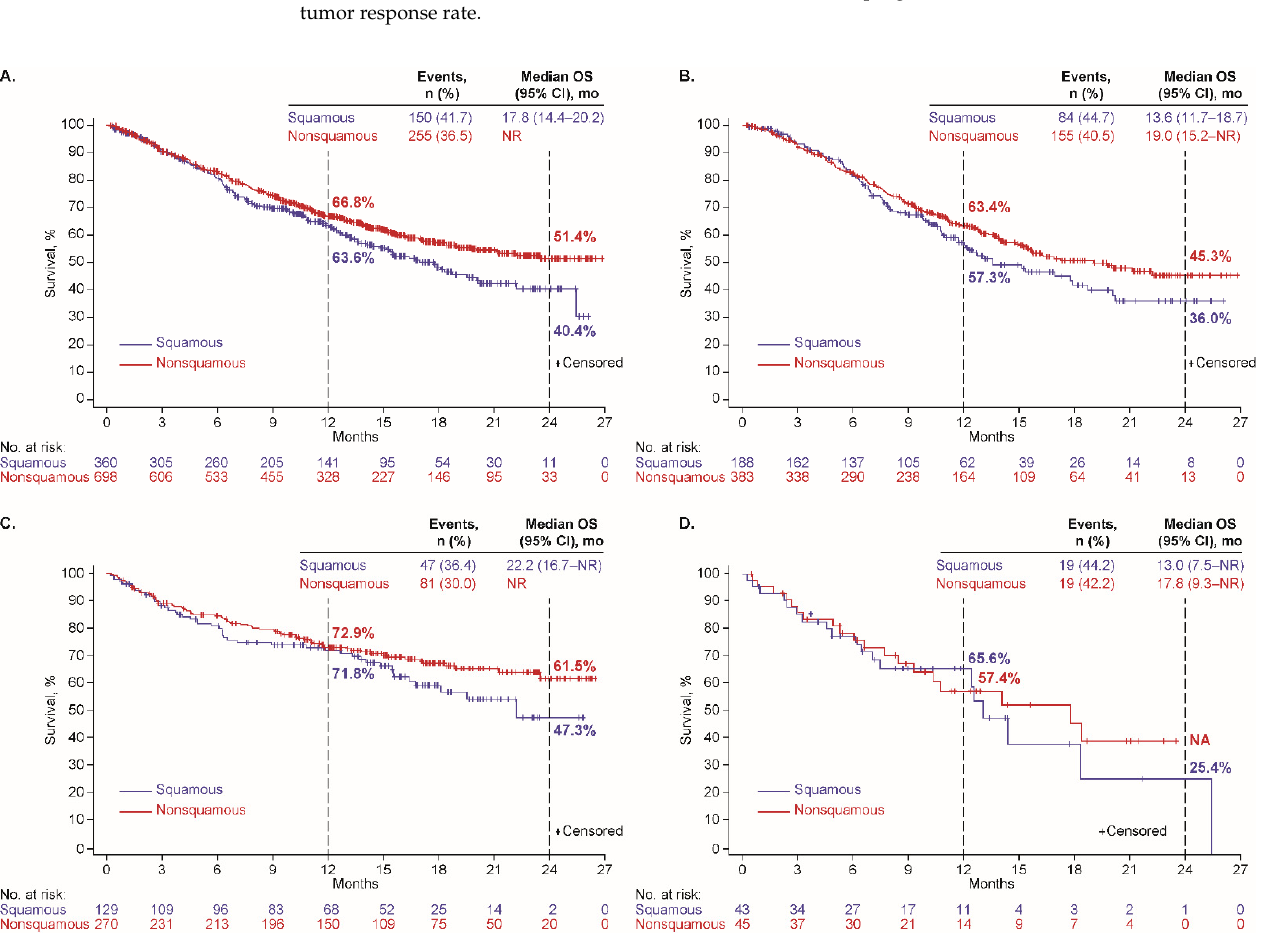
Figure 1. Overall survival by tumor histology among patients who received first-line therapy ( A ) overall and with ( B ) platinum doublet, ( C ) ICI monotherapy, and ( D ) nonplatinum cytotoxic regi-